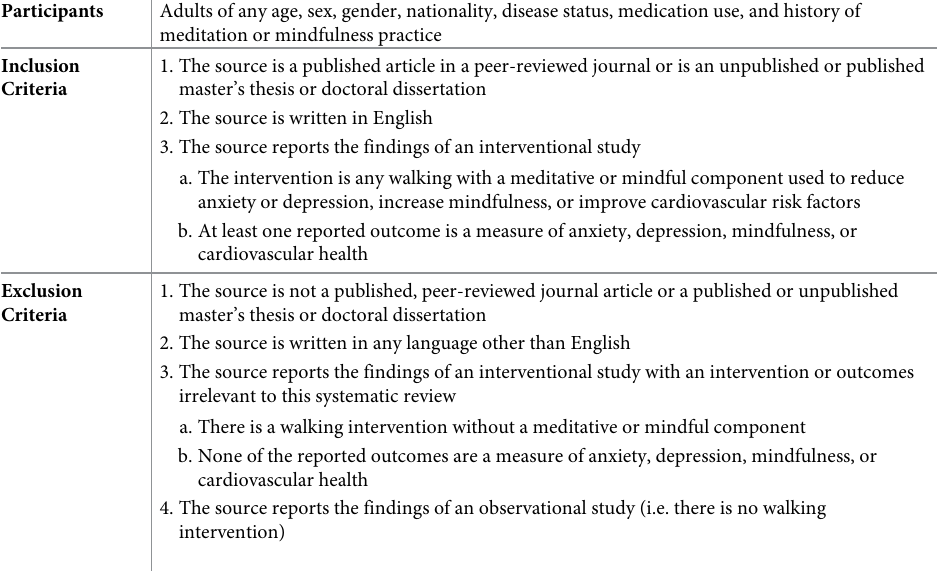
Table 2. Eligibility